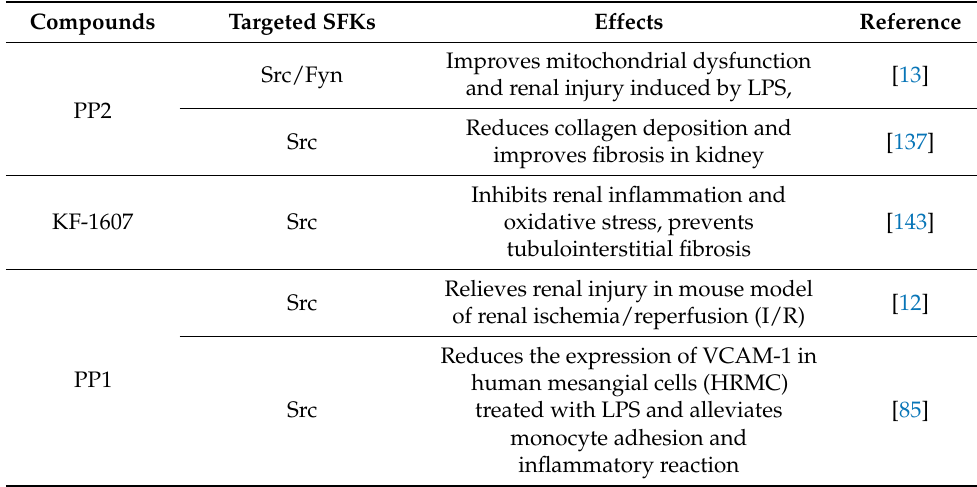
Table 2. Effect of targeting SFKs inhibitors on the pathophysiology of AKI.